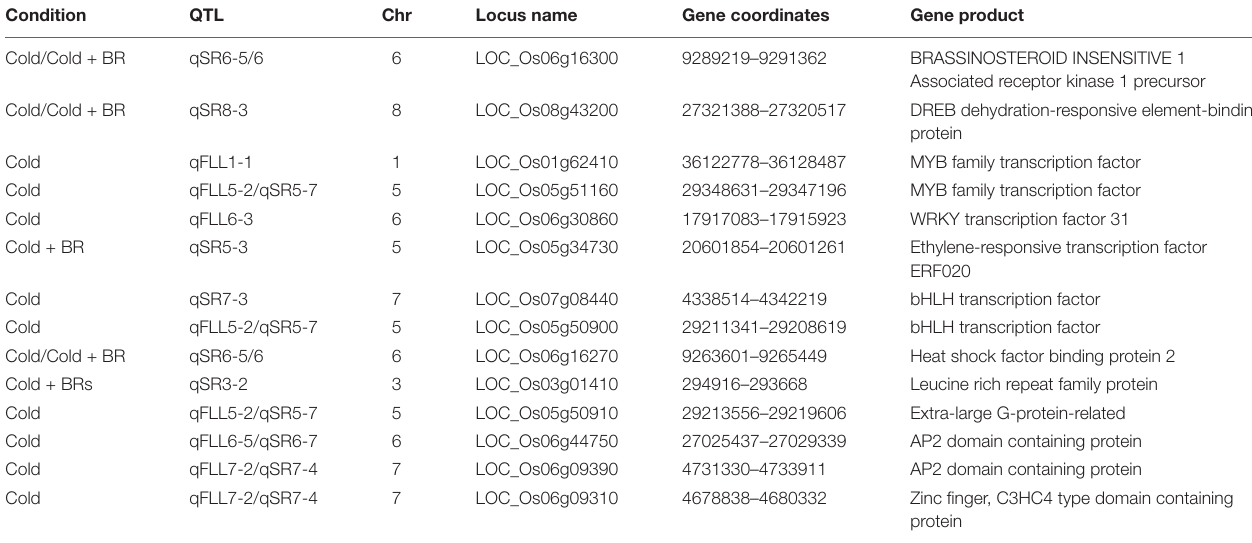
TABLE 3 | Summary of the annotated candidate genes possibly associated with cold tolerance or the BR signaling pathway. Condition QTL Chr Locus name Gene coordinates Gene